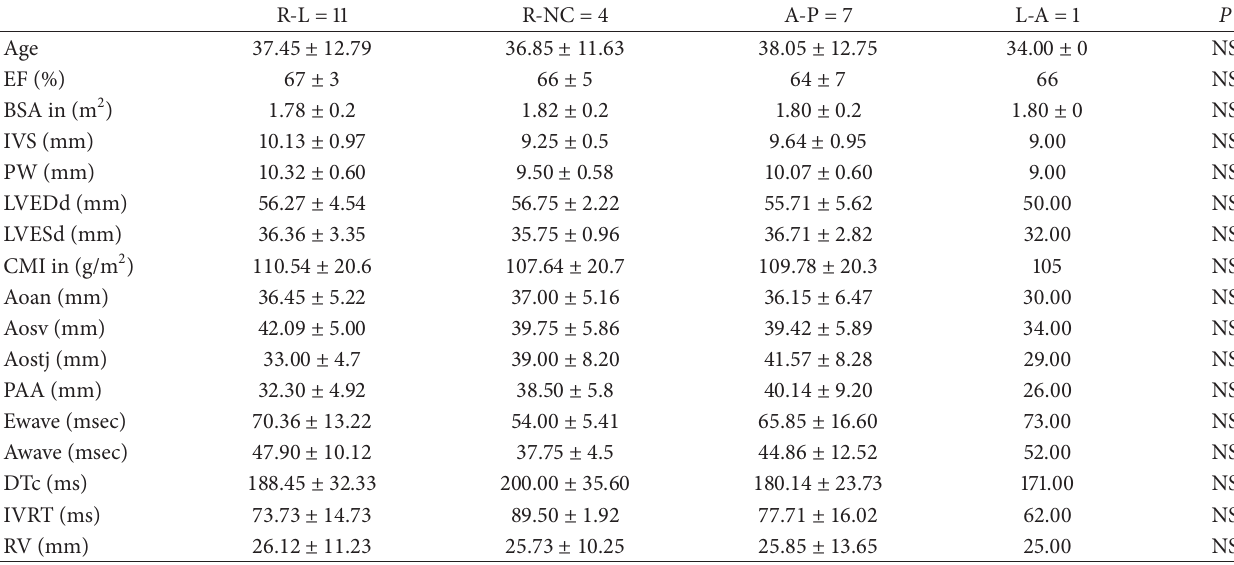
Table 5: Echocardiographic features of the ex-athletes with different types of bicuspid aortic